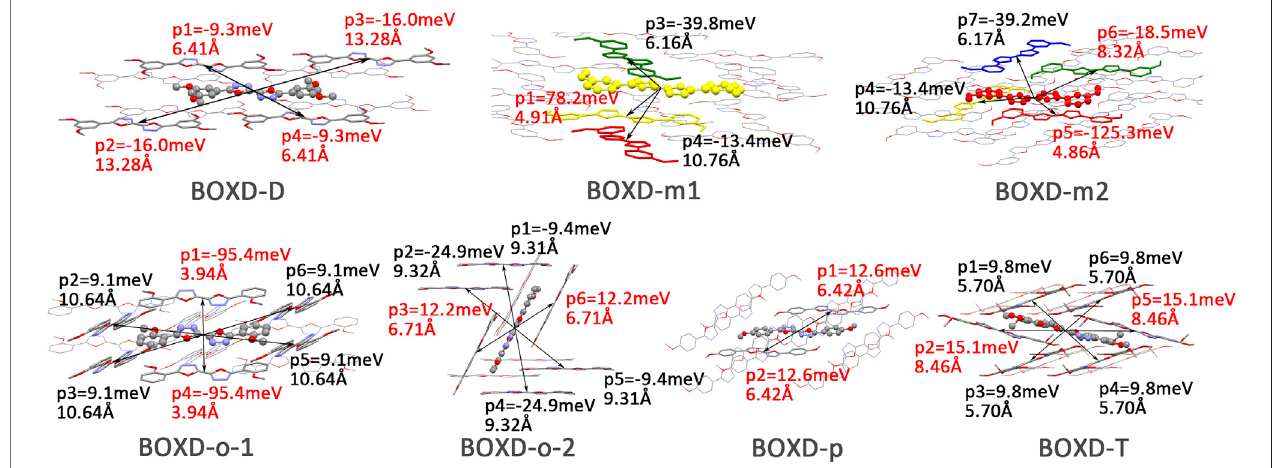
FIGURE 4 | Transfer integral and intermolecular distance of primary electron transfer paths in each crystal structure. BOXD-m1 and BOXD-m2 need to be distinguished due to the complexity of intermolecular position; the molecular color is based on Figure 1 . The transfer integral and intermolecular distance of π stacking are depicted in red, and herringbone arrangement are depicted in black.